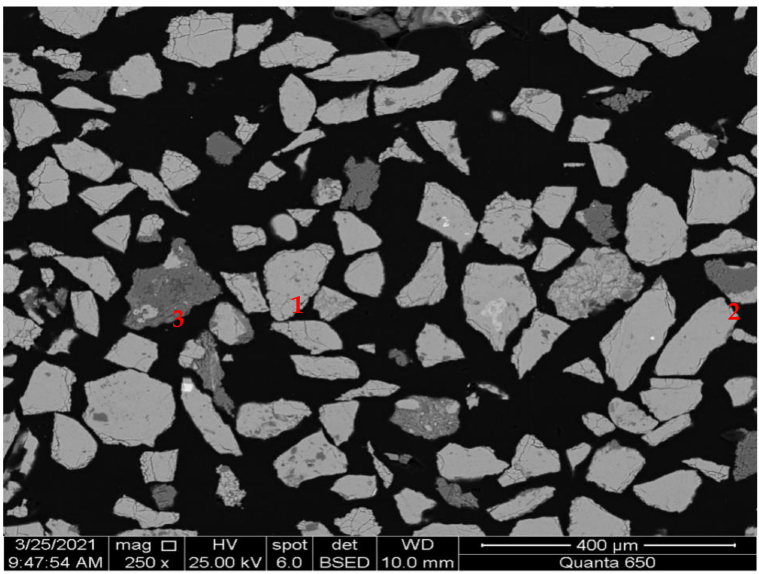
Figure 4. Main disseminated characteristics of apatite: 1 —apatite; 2 —kaolinite; 3 —sericite